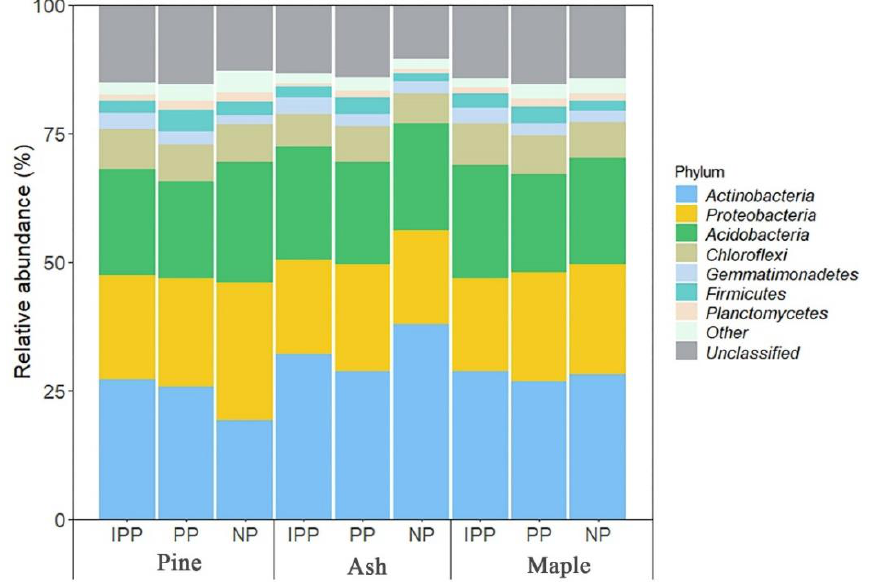
Figure 2. Soil bacterial community composition shown as relative abundance at phylum level. “Others” include phyla with less than 1% relative abundance.